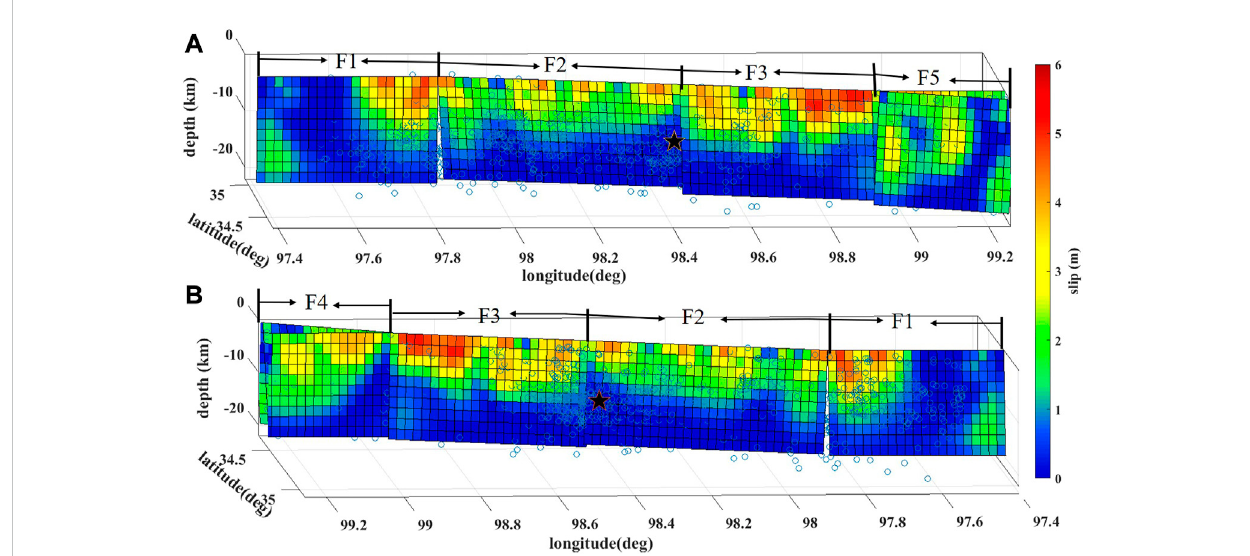
FIGURE 12 Syntheticobservation,simulation,andresidualfromcoseismicslipmodelinversionconstrainedbyEW (A – C) ,NS (D – F) andUP (G – I) displacements.